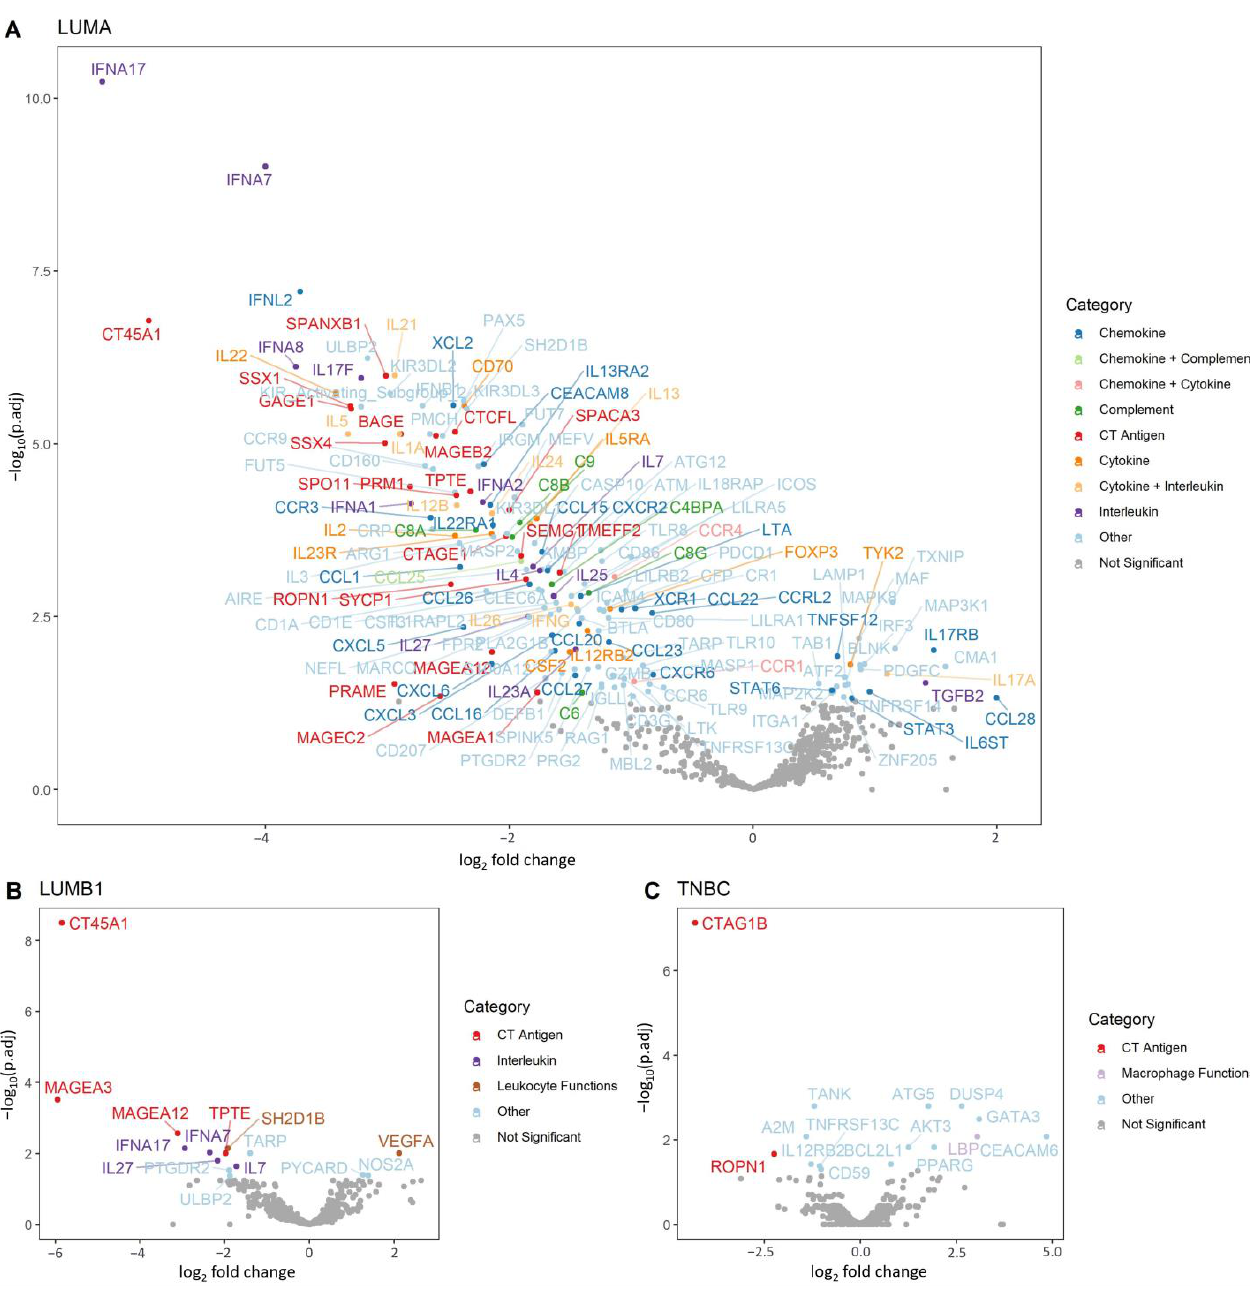
Figure 4. Differential expression analysis of immune genes (n = 730) in Met vs. Ctrl comparison for three breast carcinoma subtypes. Results are shown separately for each subtype: A, LUMA, B, LUMB1 and C, TNBC. The x-axis shows the log2 fold change between Met and Ctrl, and the y-axis shows -log10-transformed adjusted p - values from differential expression analysis. Genes that remained significant after Benjamini–Hochberg ad- justment (adjusted p < 0.05) are colored according to a reduced list of immune response categories (highlight- ing only immune response categories that showed enrichment among the differentially expressed